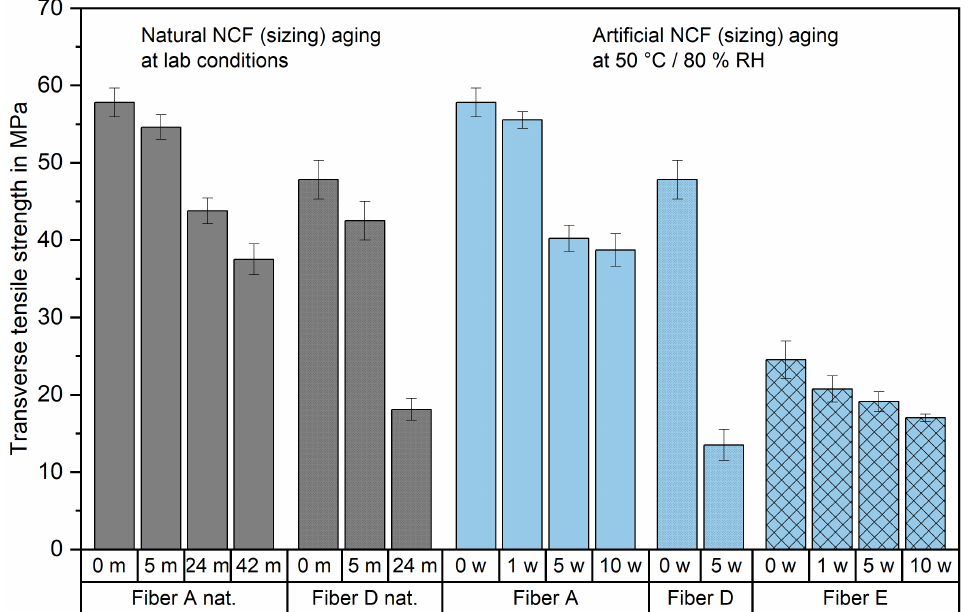
Figure 7. Development of transverse tensile strength due to standard NCF sizing aging under laboratory conditions ( left ) and tailored NCF aging at 50°C and 80% RH ( right ). Grey shades represent natural aging, blue shades accelerated aging. The duration of standard aging is given in months (m), and tailored aging is given in weeks (w).